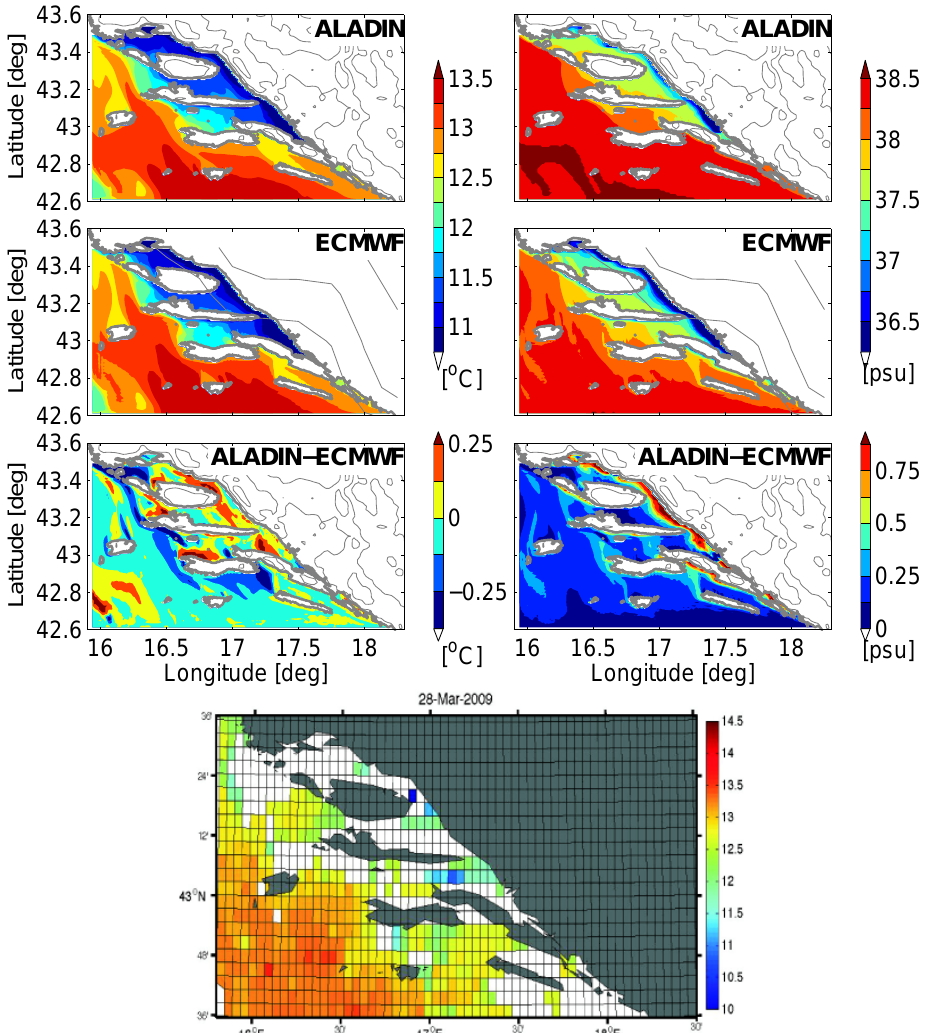
Fig. 9. Mean ASHELF-2 modeled sea surface temperatures (left panels) and surface salinities (right panels) for the Sirocco period (Table 1) obtained with ALADIN (top panels) and ECMWF (second from above) forcing and the differences between these two (third from above). The lowermost panel shows the satellite-measured sea surface temperature for 28 March 2009.